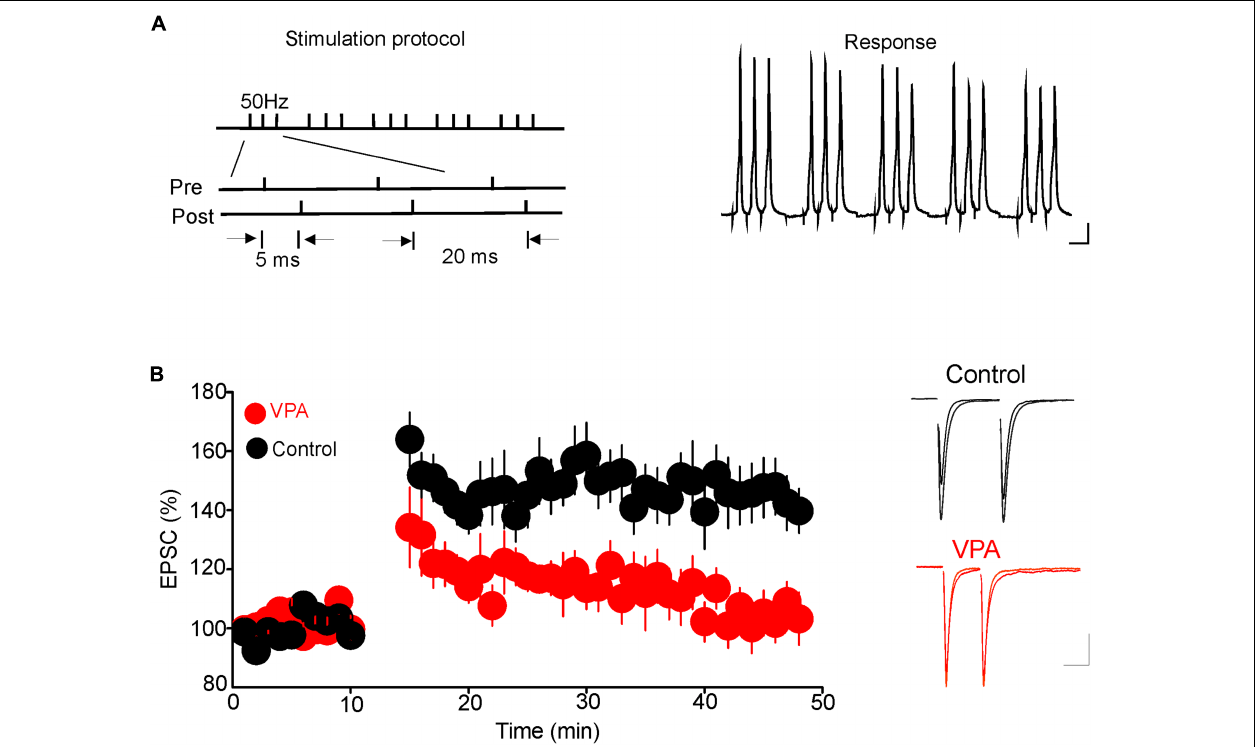
FIGURE 5 | Prenatal VPA exposure occludes the spike-timing-dependent long-term potentiation (tLTP) of glutamatergic synapses in the dorsal raphe nucleus (DRn). (A) Depicts the stimulation protocol (left traces) and the responses (right traces) during the tLTP induction. Scale bars for the traces: 25 mV (vertical), 10 ms (horizontal). (B) Lower graph illustrates the time course of the tLTP in DRn slices from control ( • ) and VPA rats ( • ). Note that pairing presynaptic stimulation with back-propagating action potentials induces a robust tLTP in control (140.5 ± 5.6 % of baseline, n = 10 cells, p < 0.01 versus baseline), but not in VPA rats (105.4 ± 3.6 % of baseline, n = 10 cells, p > 0.05 versus baseline). Right traces are superimposed excitatory postsynaptic currents recorded pre- and post-application of the tLTP induction protocol in slices from control (upper traces) and VPA rats (lower traces). Data are presented as Mean ± SEM. Scale bars for the traces: 50 pA (vertical), 20 ms